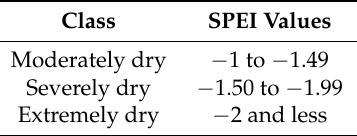
Table 1. The units of deviation from the mean of a standardized Gaussian distribution and the correspondent measure of the severity of a dry